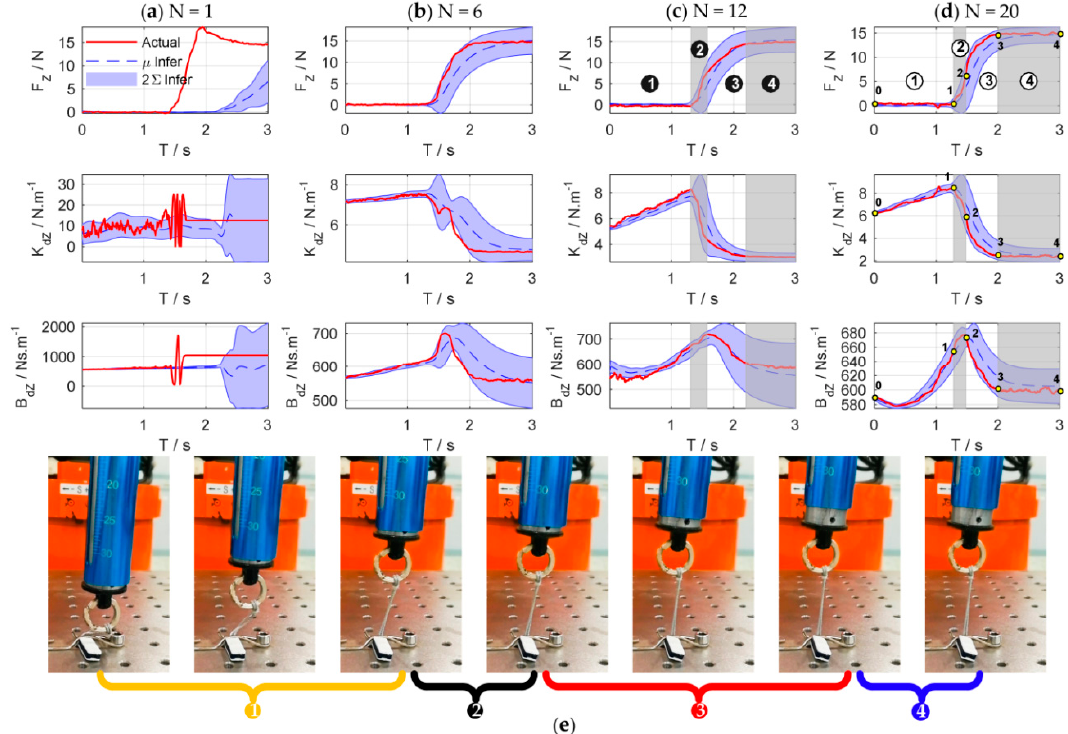
Figure 17. States evolution of force control. Columns ( a – d ) are the state evolutions of the 1st, 6th, 12th, and 20th learning iteration, respectively. The top row shows the contact force F z , the second row shows the profile of stiffness K dz , and the third row shows the profile of damping B dz .